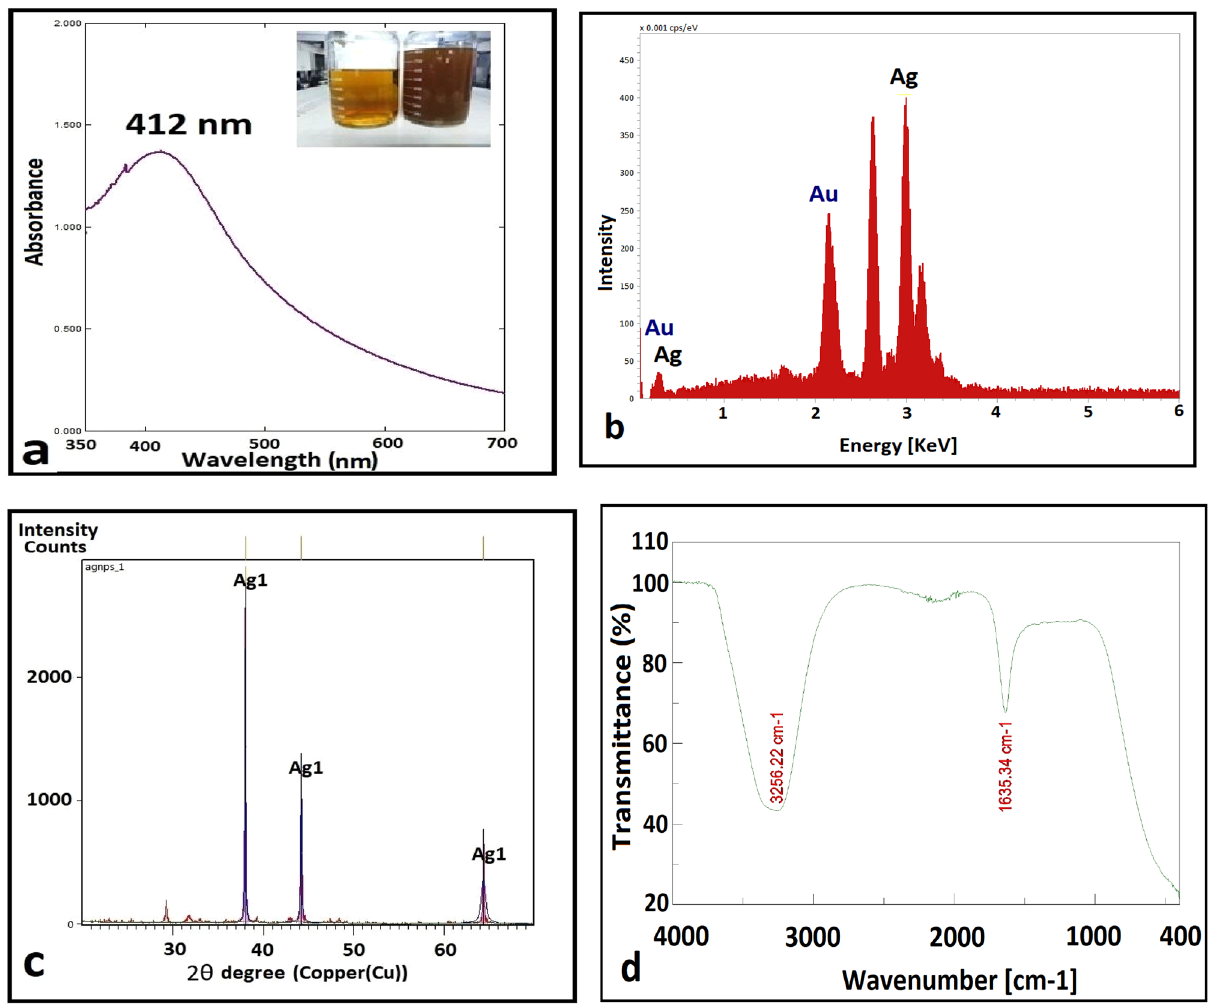
Figure 2. The positive result of color change and UV–visible spectroscopy of biosynthesized Ag NPs (a), EDX analysis (b), XRD results (c), and FT-IR spectra analysis (d) 390, and 440 nm, respectively. The precise mechanism underlying the biosynthesis of Ag NPs by bacteria is still unknown. However, it has been reported that metal ions are reduced to form NPs by enzymes such as nitrate reductase, and that these biomolecules are secreted by microbial cells in the matrix, which can act as both reduc- ing and stabilising agents 22 . The absorption band at 400–420 nm is known to be caused by surface plasmon reso- nance (SPR) in Ag NPs and may be a property of noble metal NPs 43 . In the absorption spectra of spherical metal NPs, a single SPR band would be expected. For Ag NPs, a peak between 410 and 440 nm was observed, as is well known for metallic NPs with sizes ranging from two to 100 nm 22 . In our study, a single SPR peak was observed, indicating that the metal NPs were spherical in shape and parallel to the TEM images. The highest intensity absorption peak of silver at 3 keV was observed in the EDX spectroscopy of Ag NPs (Fig. 2b) confirming the formation of metallic Ag NPs crystalline in nature due to surface plasmon resonance 1,22 . As a result of the Au grid used for EDX analysis, additional Au peaks were discovered. Our XRD results confirm the nanocrystalline structure of biosynthesized Ag NPs. The Ag NPs showed some typical diffraction peaks at 2θ of about 38.037°, 44.205°, and 64.344° (labelled as Ag in Fig. 2c), corresponding to planes 111, 200, and 220, respectively. These diffraction peaks matched the cubically centred faces of the standard silver crystal (JCPDS file no.98–018-0878), as reported in 37,44 . These sharp Bragg peaks could be caused by capping agents that stabilise Ag NP 15 . The FT-IR spectroscopy was carried out to confirm potential interactions between silver salts and capping proteins, which could explain the reduction of silver ions and the subsequent stabilisation of Ag NPs (Fig. 2d). Representative spectra of Ag NPs revealed two prominent absorption peaks at 3256.22 and 1635.34 cm −1 , cor- responding to amino group (NH) and carbonyl group (C=O) stretching vibrations, respectively. The presence of amino and carbonyl groups is associated with peptides 1,44 . The FT-IR pattern indicates the presence of capping proteins in the silver solution NP and demonstrates that these proteins are not highly aggregated. The carbonyl groups and free amines of the bacterial proteins may be responsible for the NPs’ formation and stability. Protein